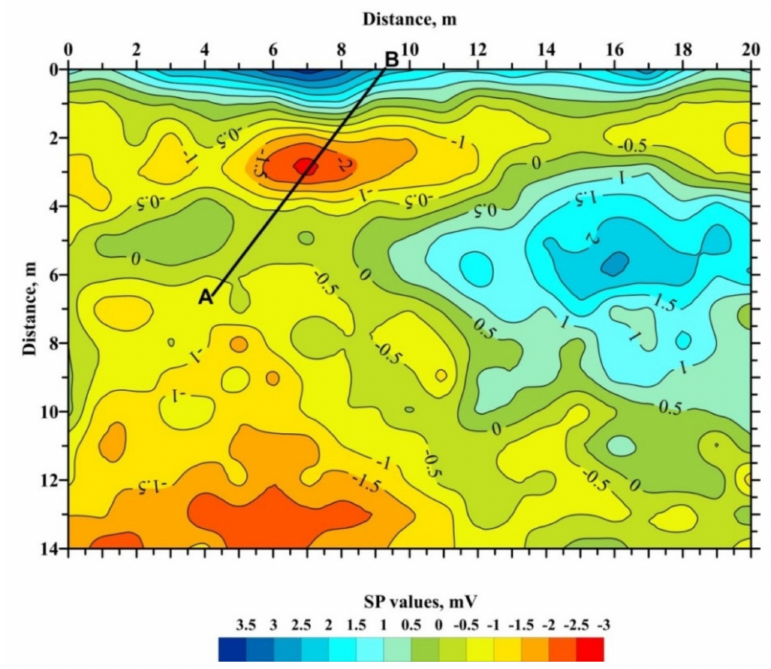
Figure 15. Self-potential map observed in the site of Emmaus-Nikopolis (central